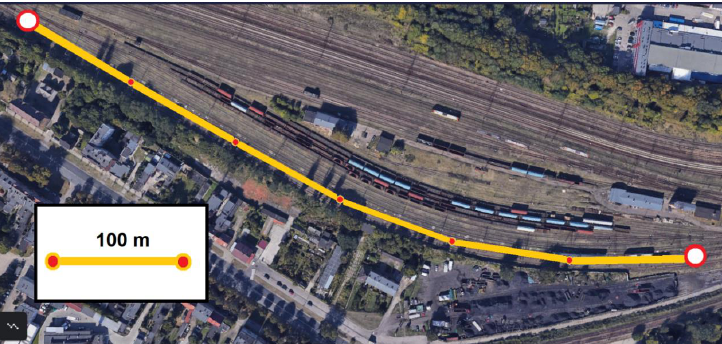
Figure 19. The route of test runs with a length of 600 m on the Bydgoszcz-Towarowa railway siding.